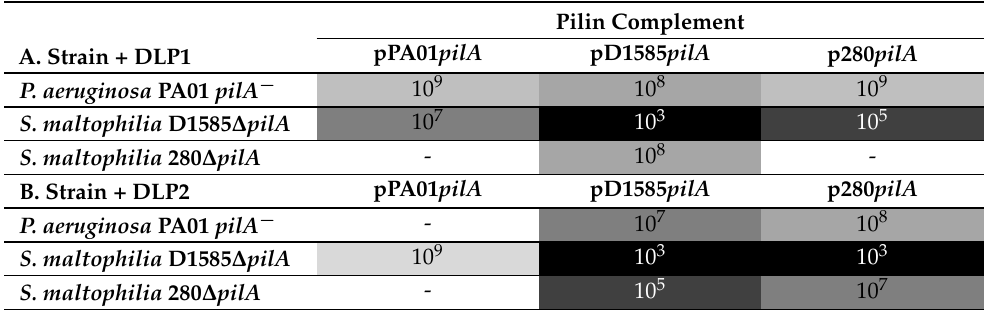
Darker shading indicates increased susceptibility to phages: no infection, clearing at 10 9 , plaquing at 10 9 , clearing at 10 8 , plaquing at 10 7 , plaquing at 10 5 , plaquing at 10 3